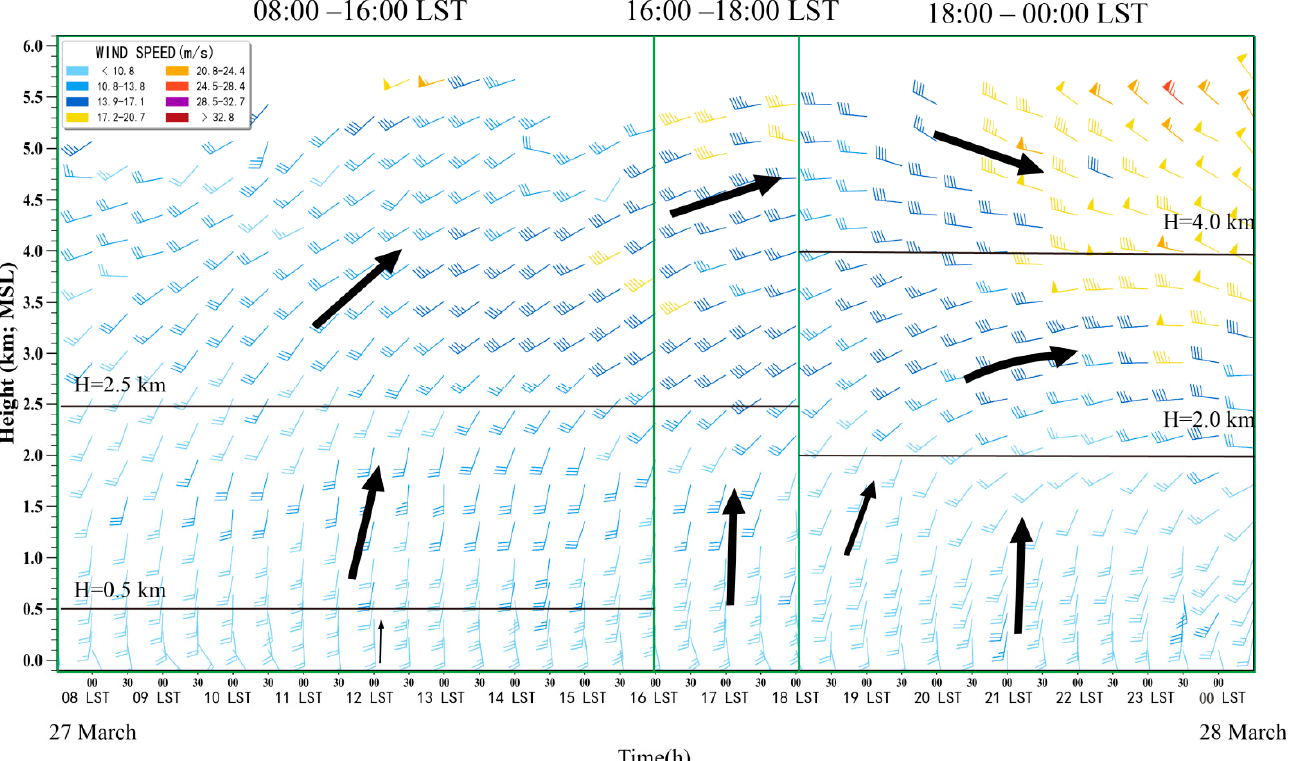
Figure 7. Winds revealed by the Hailing Island wind profile radar from 08:00 on 27 to 00:00 on 28 March (LST). Color is used to divide the wind speed into 8 grades, with 8 different wind speeds represented by the colors in the upper left corner. A long line represents a wind speed of 4 m·s － 1 , a short line represents 2 m·s － 1 , and a flag represents 20 m·s － 1 .